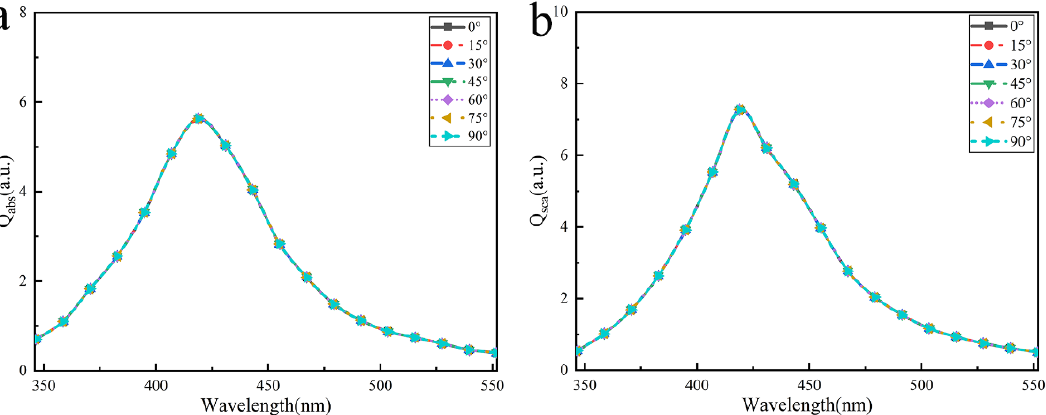
Figure 7. The absorption and scattering efficiencies of the 3 × 3 square array of Ag nanoparticles at different illumination polarization angles with particle radius R = 14 nm and particle spacing d = 10 nm : ( a ) absorption efficiency ( b ) scattering